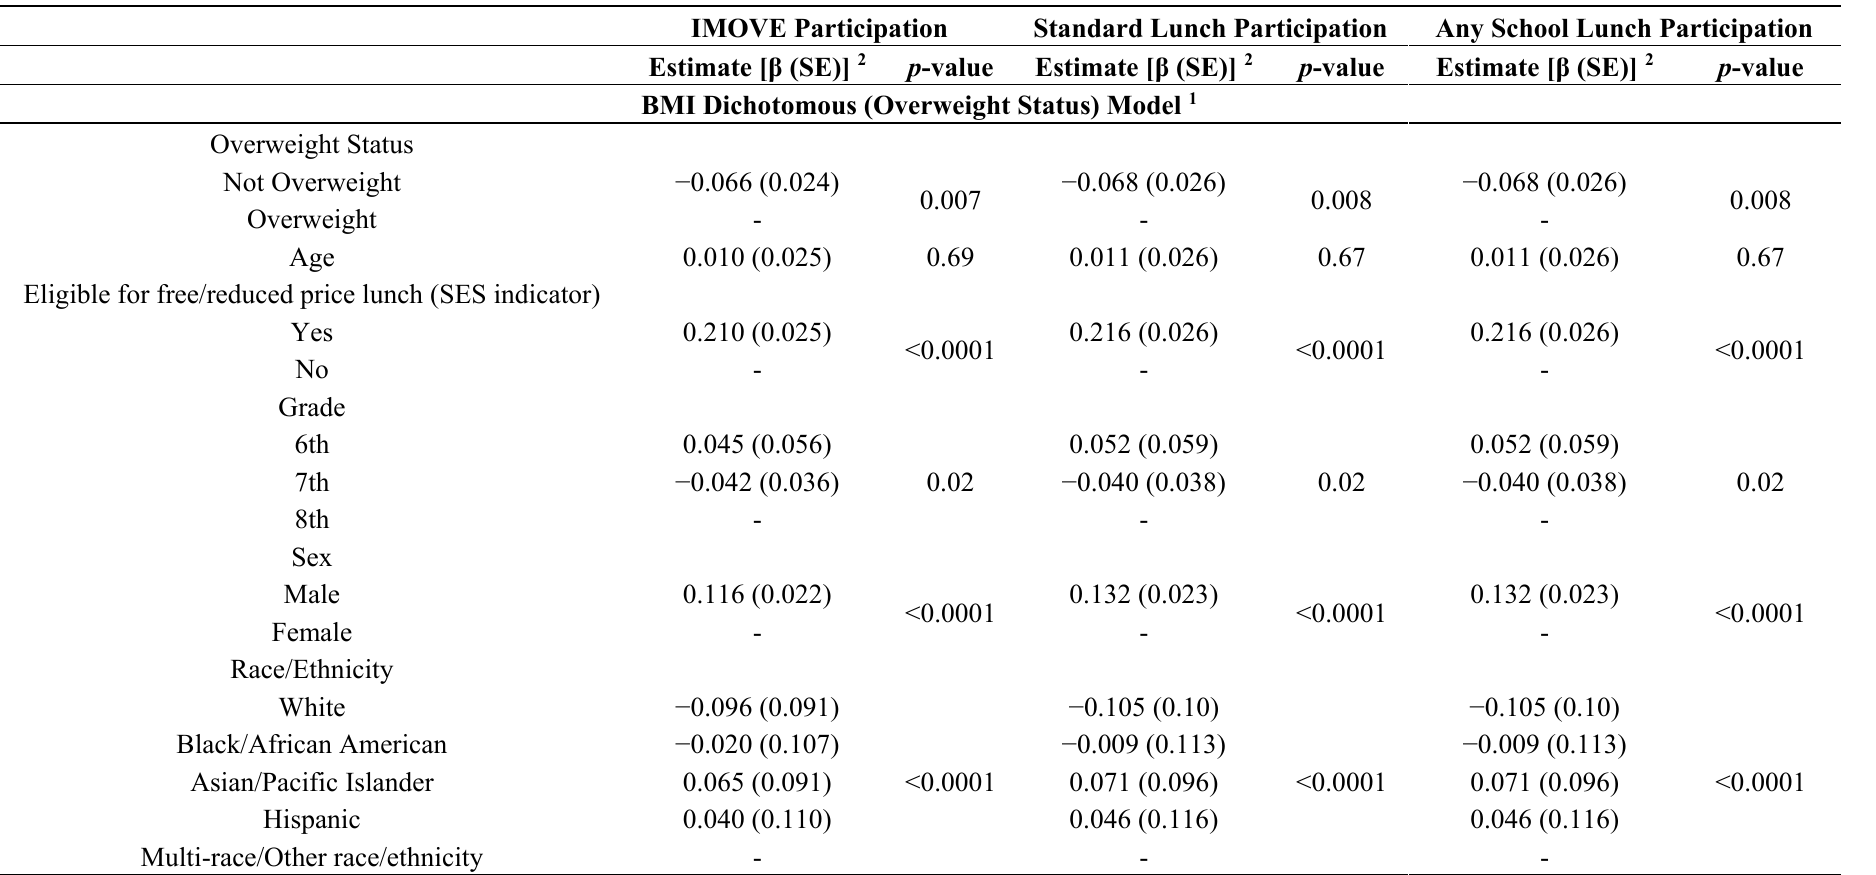
Table 4. Effect of BMI and Other Covariates on Participation Rates for IMOVE Lunch, Standard School Lunch, and Any School Lunch ( n =